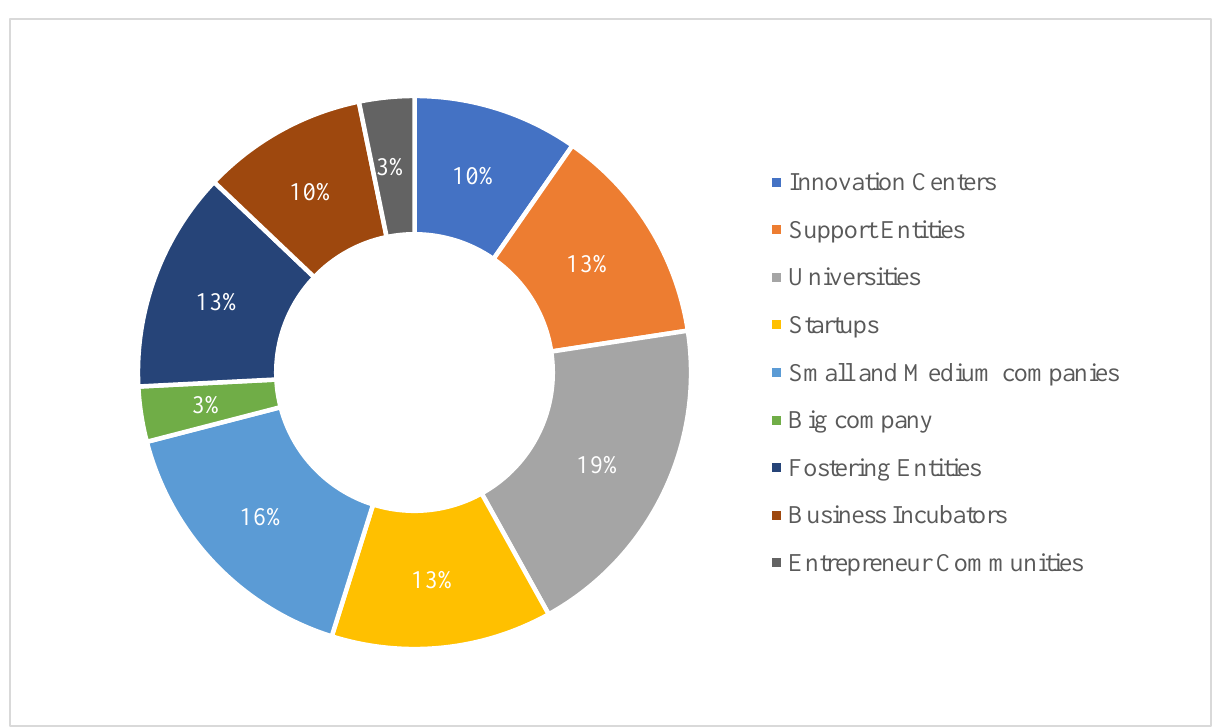
Figure 2. Categories of companies that responded to the data collection instrument.